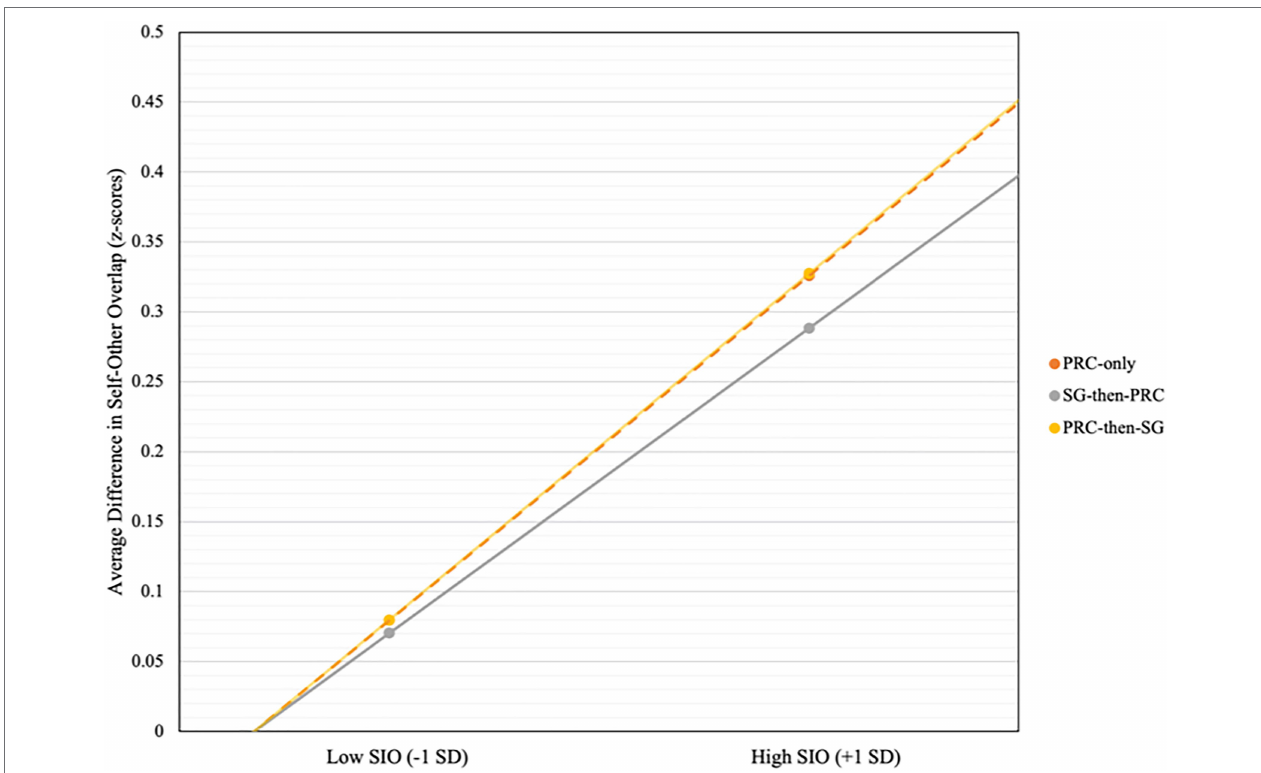
FIGURE 6 | Comparison of indirect effects of the PRC-only, SG-then-PRC, and PRC-then-SG conditions on differences in self-other overlap (closeness) moderated by social identity orientation (SIO). Slopes represent conditional indirect effects of each embodiment condition via empathy, based on values when SIO is − 1 SD and + 1 SD from the mean. For high SIO (+1 SD) participants, all three conditions produced significant indirect